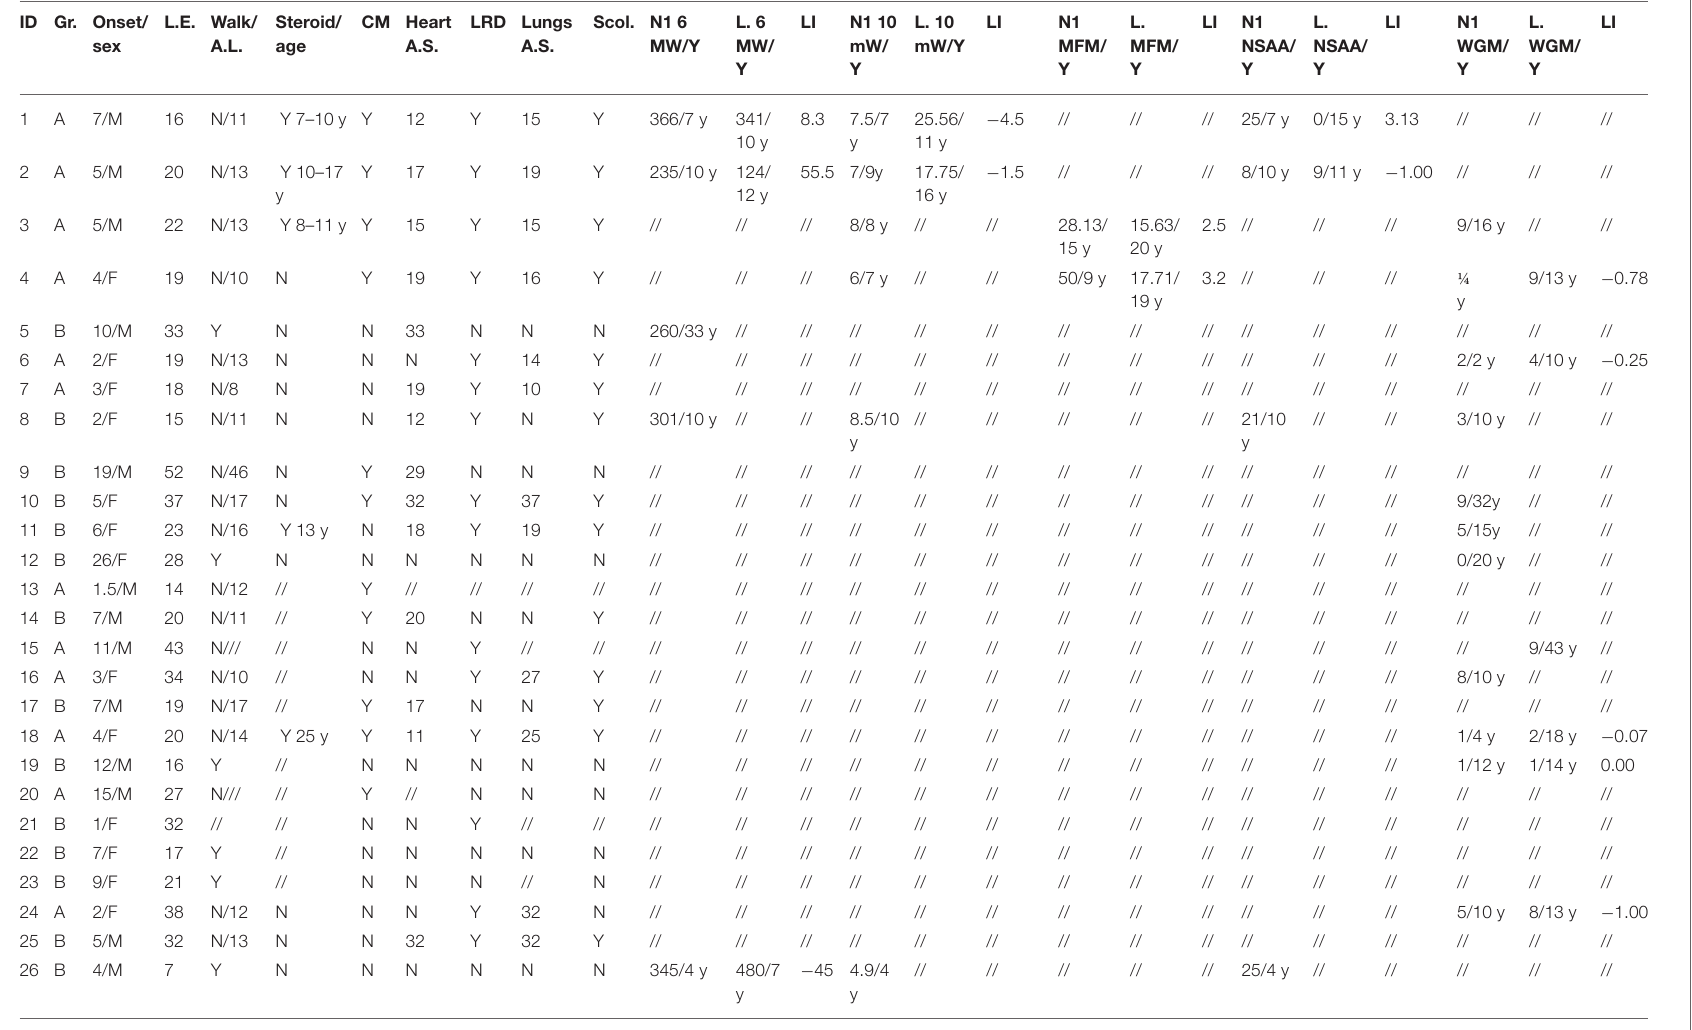
TABLE 4 | Demographic and clinical features of the studied cohort. ID Gr. Onset/